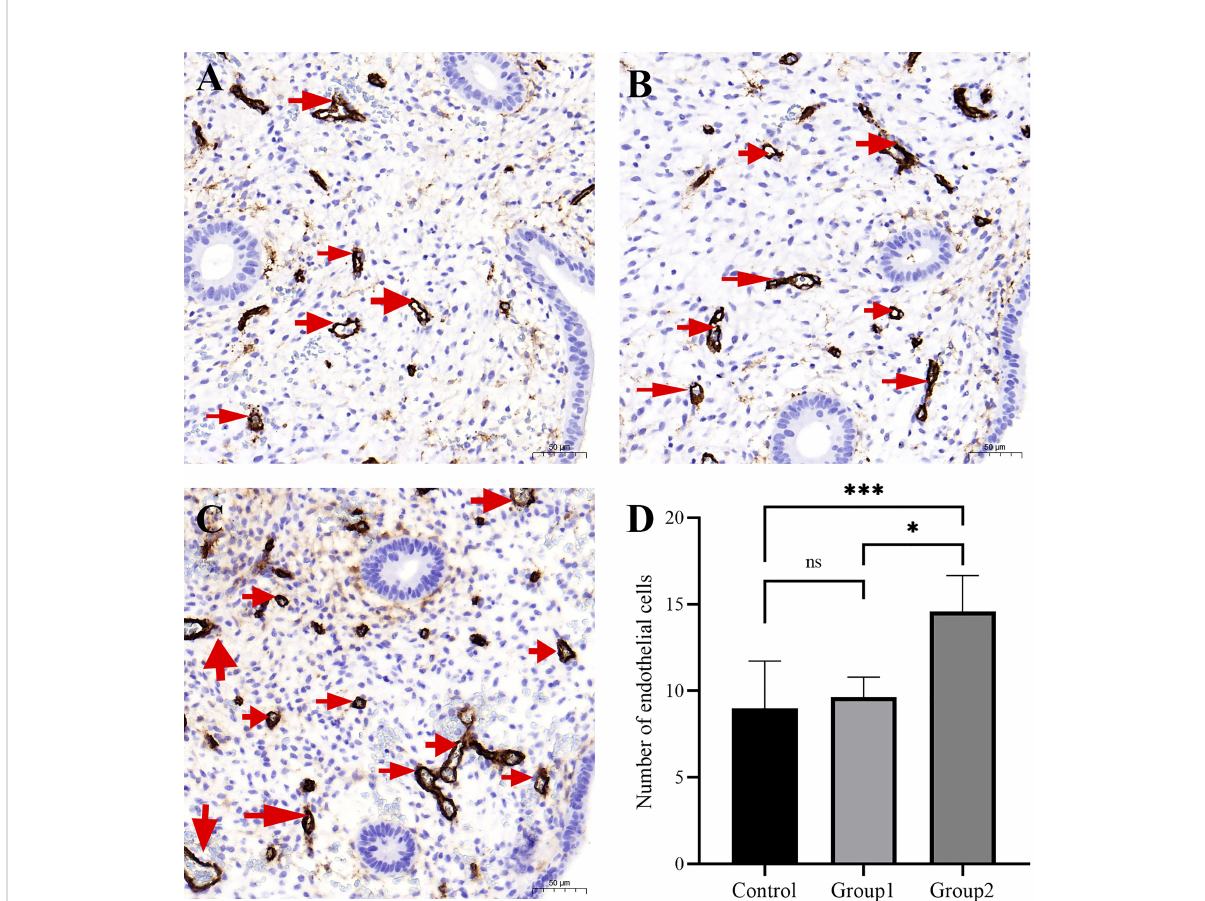
FIGURE 4 The micro-blood vessels in endometrial biopsies were determined by CD34 – stained sections. Representative images of blood vessels localized in endometrium (arrows) from the fertile controls (A) , CD138+ 1 – 4/10 HPFs group (B) , and CD138+ ≥ 5/10 HPFs group (C) are shown. Original magni fi cation, ×200. Scale bar = 50 m m. The CD138+ ≥ 5/10 HPFs group exhibited the highest MVD values (D) . *, P < 0.05; ***, P < 0.01; ns, P >